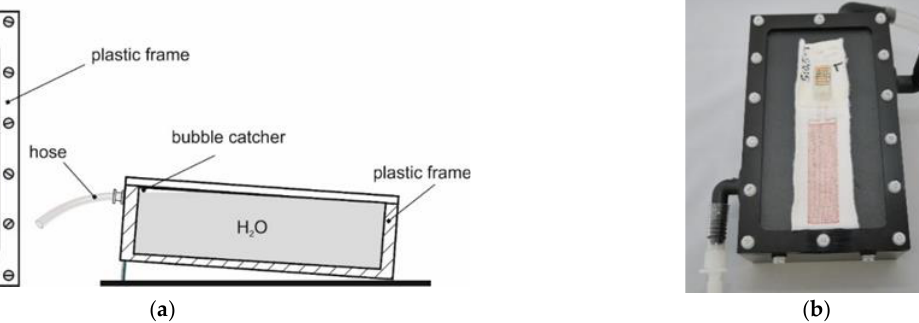
Figure 1. ( a ) Diagrams of the technical moisture model (top view and cross-section). ( b ) Photograph of the model.